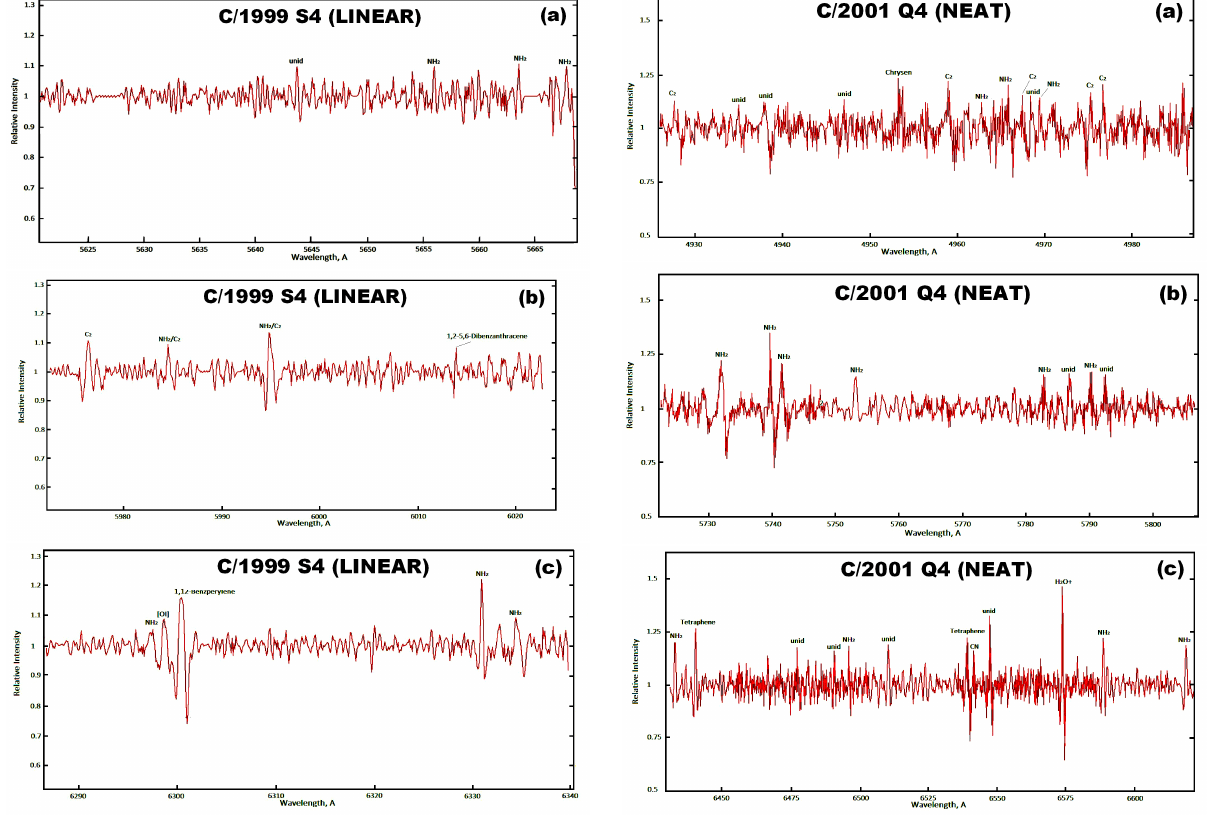
Figure 2. Three fragments of 40 th spectral order of normalized echelle spectrum of C/2001 Q4 (NEAT) with the continuum removed and solar spectrum